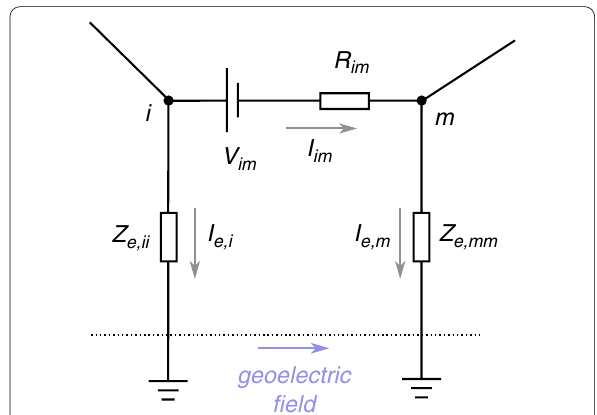
Fig. 2 A schematic representation of the equivalent electric circuit between two nodes (that are both connected to the rest of the network) involved in the Lehtinen–Pirjola